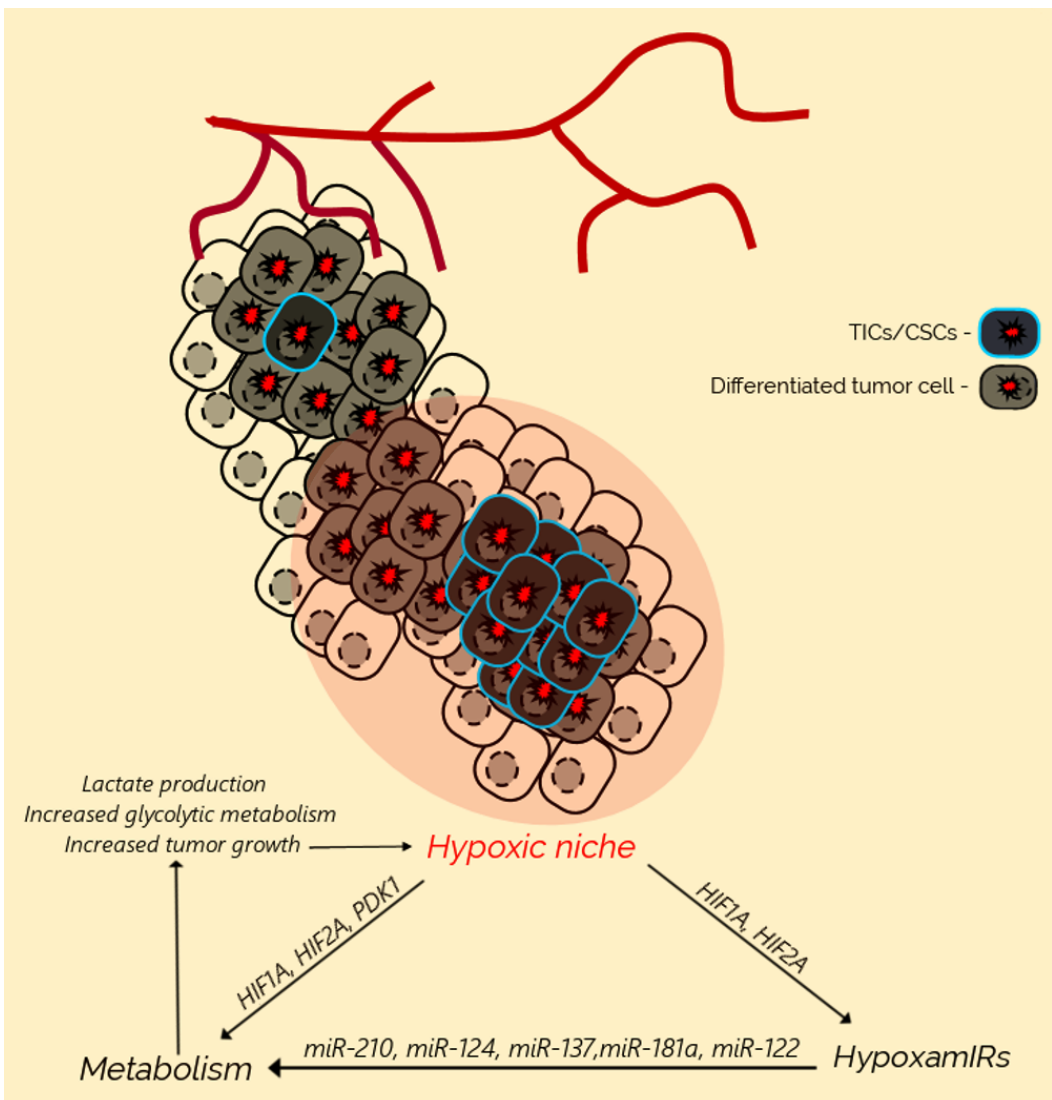
Figure 1. Hypoxia, miRNAs, and metabolism in the tumor niche. The local hypoxic niche in the tumor leads to both the activation of hypoxamiRs, such as miR-210, and extensive metabolic changes, via genes such as HIF1A , which in turn drive pro-tumorigenic characteristics such as lactate production and glycolytic metabolism, leading to tumor